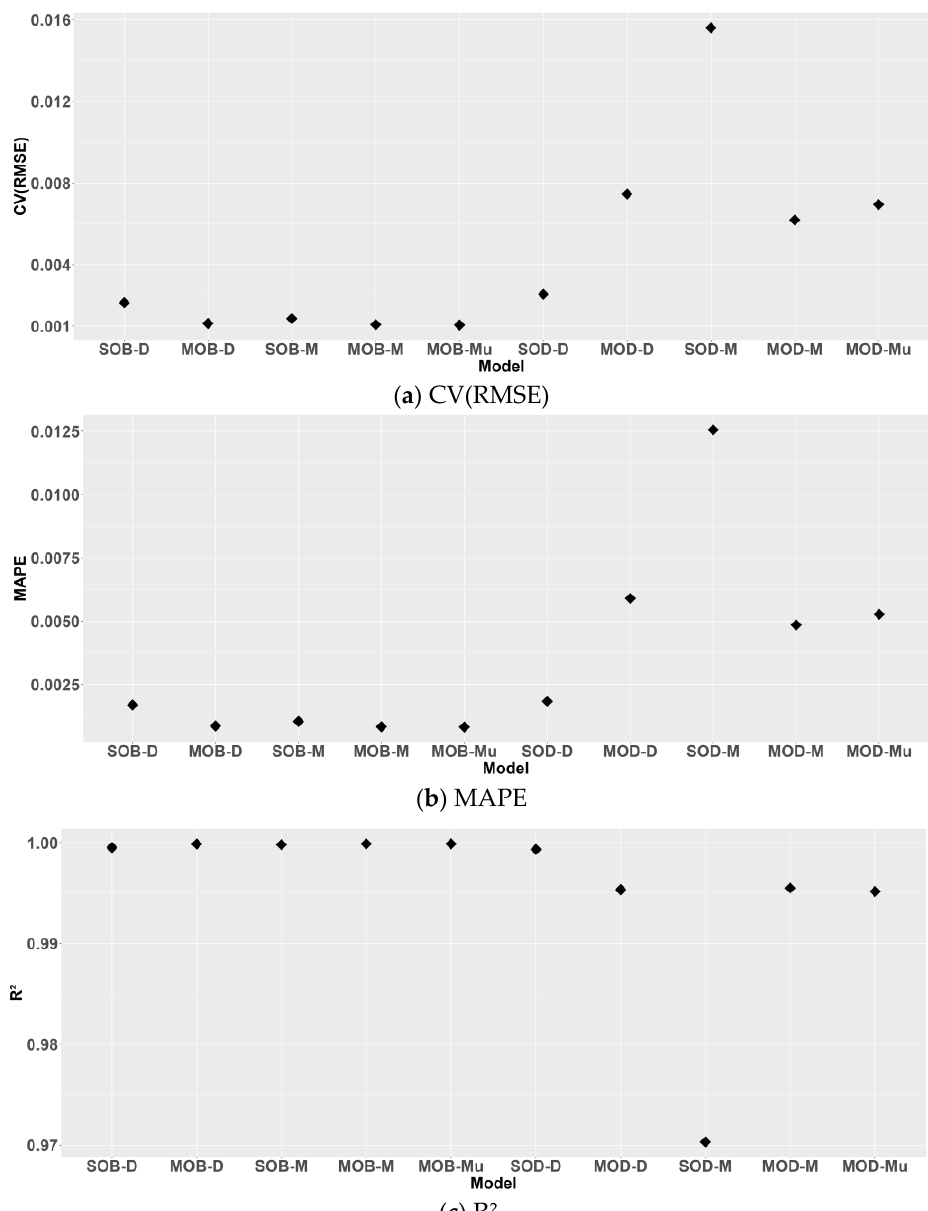
Figure 11. Performance of 10 models for annual cooling energy (refer to Table 4 for model explana- tion).